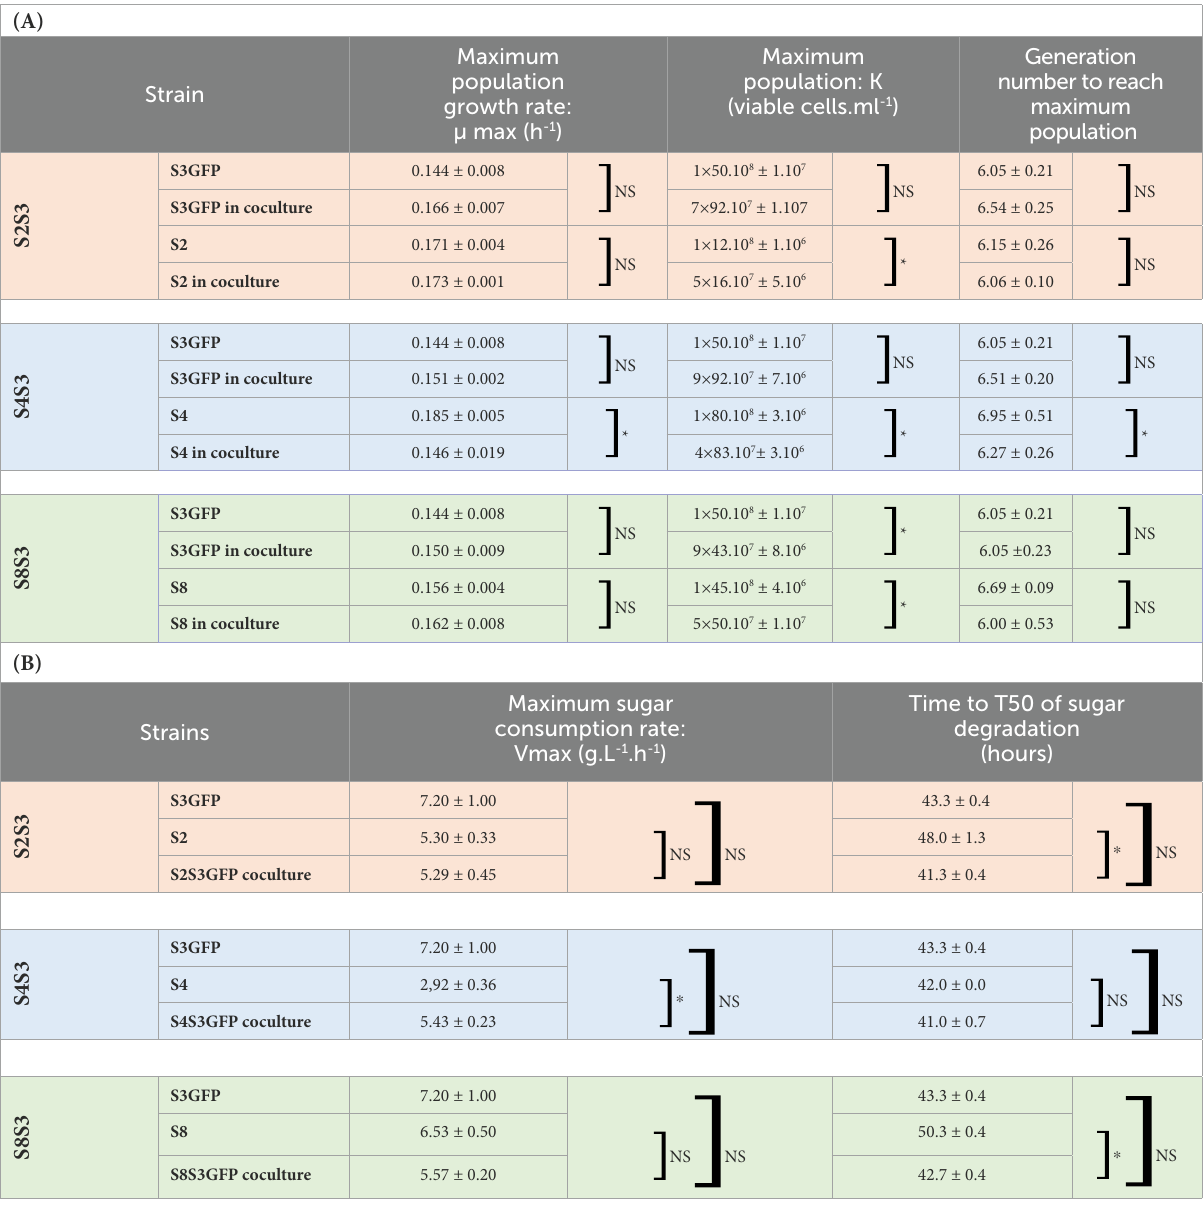
TABLE 1 Impact of coculturing on growth and fermentative kinetics